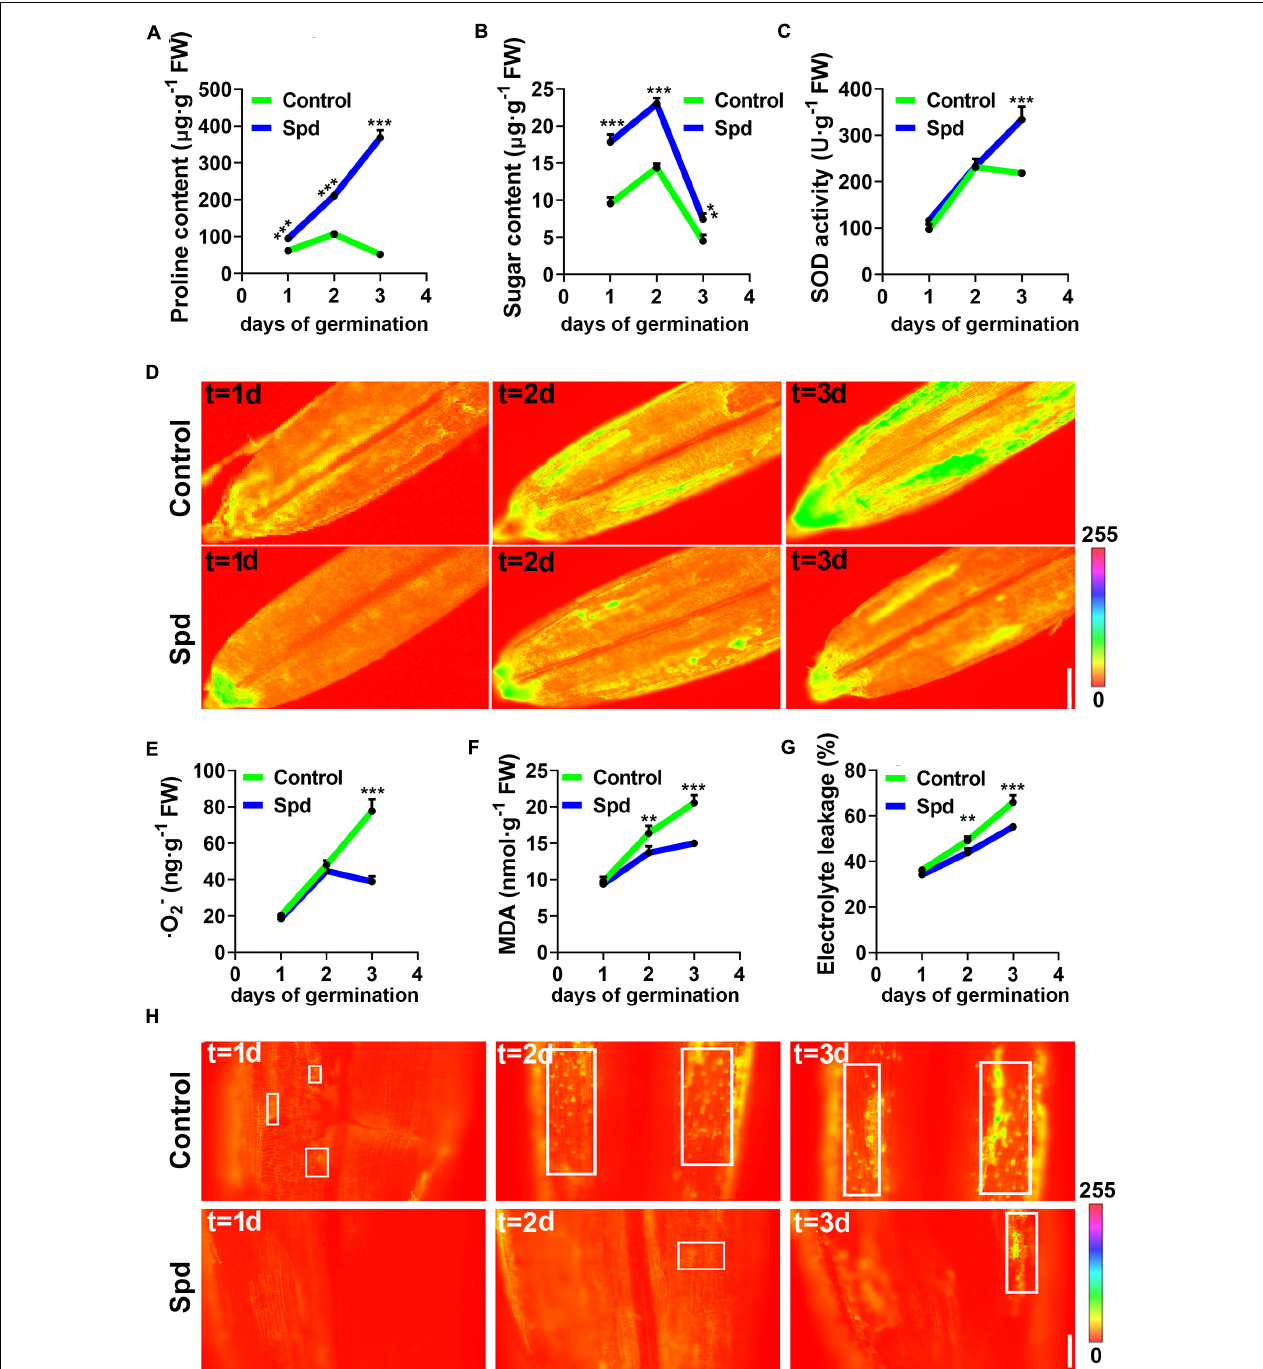
FIGURE 6 | Changes of the osmotic signals under salt-alkali stress. (A) Content of Proline. (B) Content of sugar. (C) SOD activity. (D) Representative pseudo-color images of O 2 - . bar = 0.1 cm. (E) Content of O 2 - . (F) Content of MDA. (G) Electrolyte leakage. (H) Representative pseudo-color images, bar = 100 µ m. SOD, superoxide dismutase; MDA, malondialdehyde. Vertical bars indicate mean ± SD ( n = 3), and ** or *** indicates a significant difference at the level of p < 0.001.